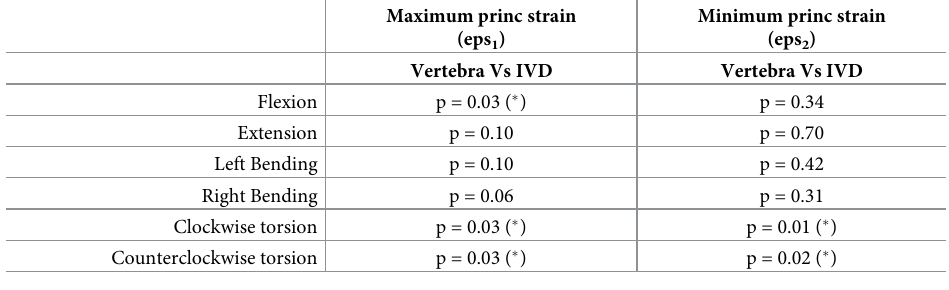
Table 2. The reported p-values show the statistical significance of the difference between the median on the verte- brae and intervertebral discs for the same loading condition (two-sample Mann-Whitney test). The median of strains on the ALL in front of the L4 vertebra and the L4-L5 intervertebral disc were